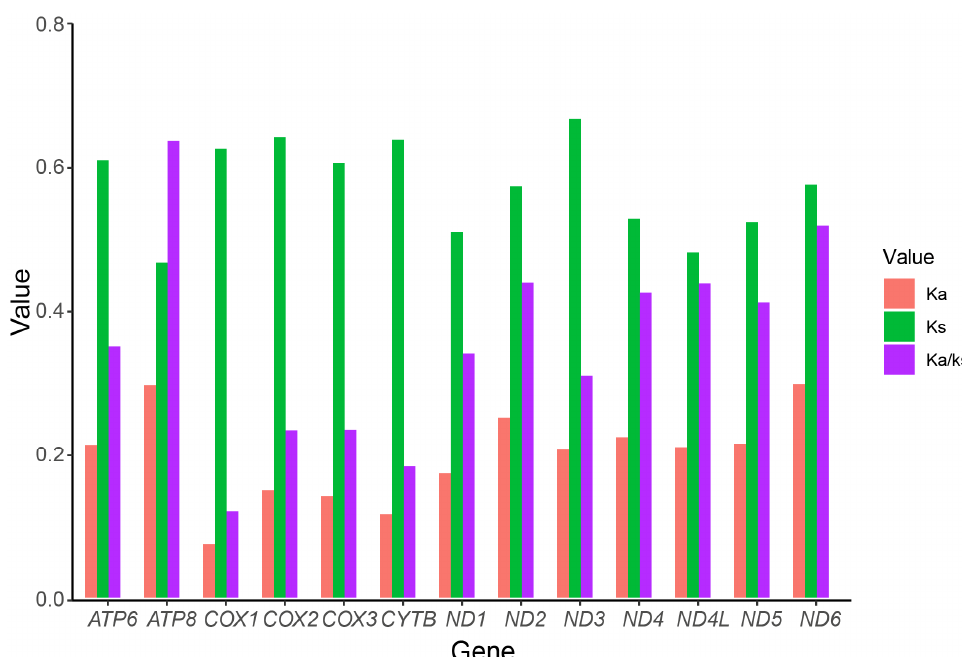
Figure 5. Evolutionary rate of each PCG of the mitogenomes of philopotamid